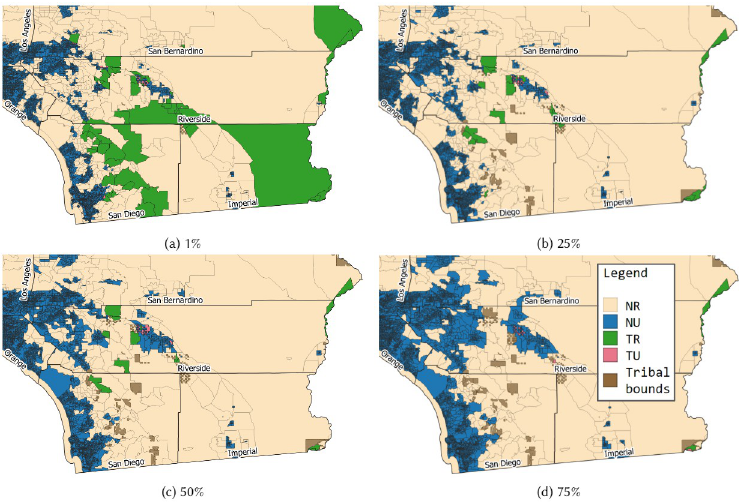
Fig 5. Urban/rural and tribal/non-tribal clustering variations for SoCal counties with tribal presence. BGs in SoCal are labeled as urban (U) or rural (R) and tribal (T) or non-tribal (N) according to the percentage of constituent blocks (for U/R) or area (for T/N) with that label. Shown here are block group labels for four percentage thresholds of constituency, referred to as labeling thresholds : 1% (any rural or tribal makeup), 25%, 50%, and 75% (majority rural or tribal makeup). The labels are cross-combined to create the following clusters: Blue areas are non-tribal urban (NU), orange are non-tribal rural (NR), green are tribal urban (TU), and red are tribal rural (TR). This variation in cluster labeling serves as a proxy for varying the underlying BGs that could be assigned each label, subject to different interpretations of the definition of rural and tribal . Our precision analysis examines how much variation may be introduced into final calculations of rural or tribal mobility depending on the clustering threshold, and considers the corresponding variation in sample size, device density, and population that make up the mobility dataset in each cluster. This figure was generated by the authors from the public census datasets noted in the Materials section [45, 46, 49].